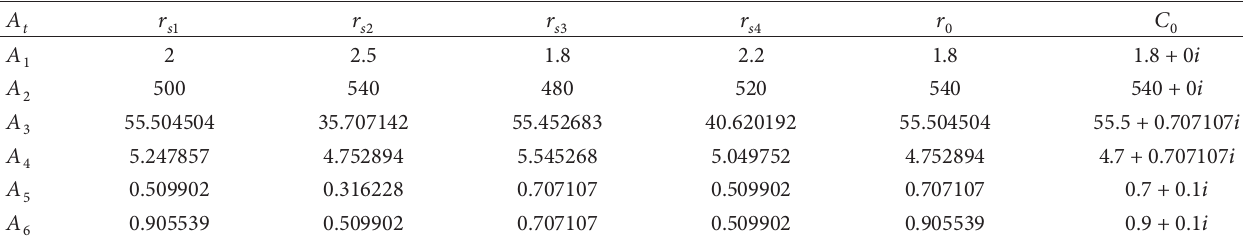
Table 4: The module of every index and the target center index